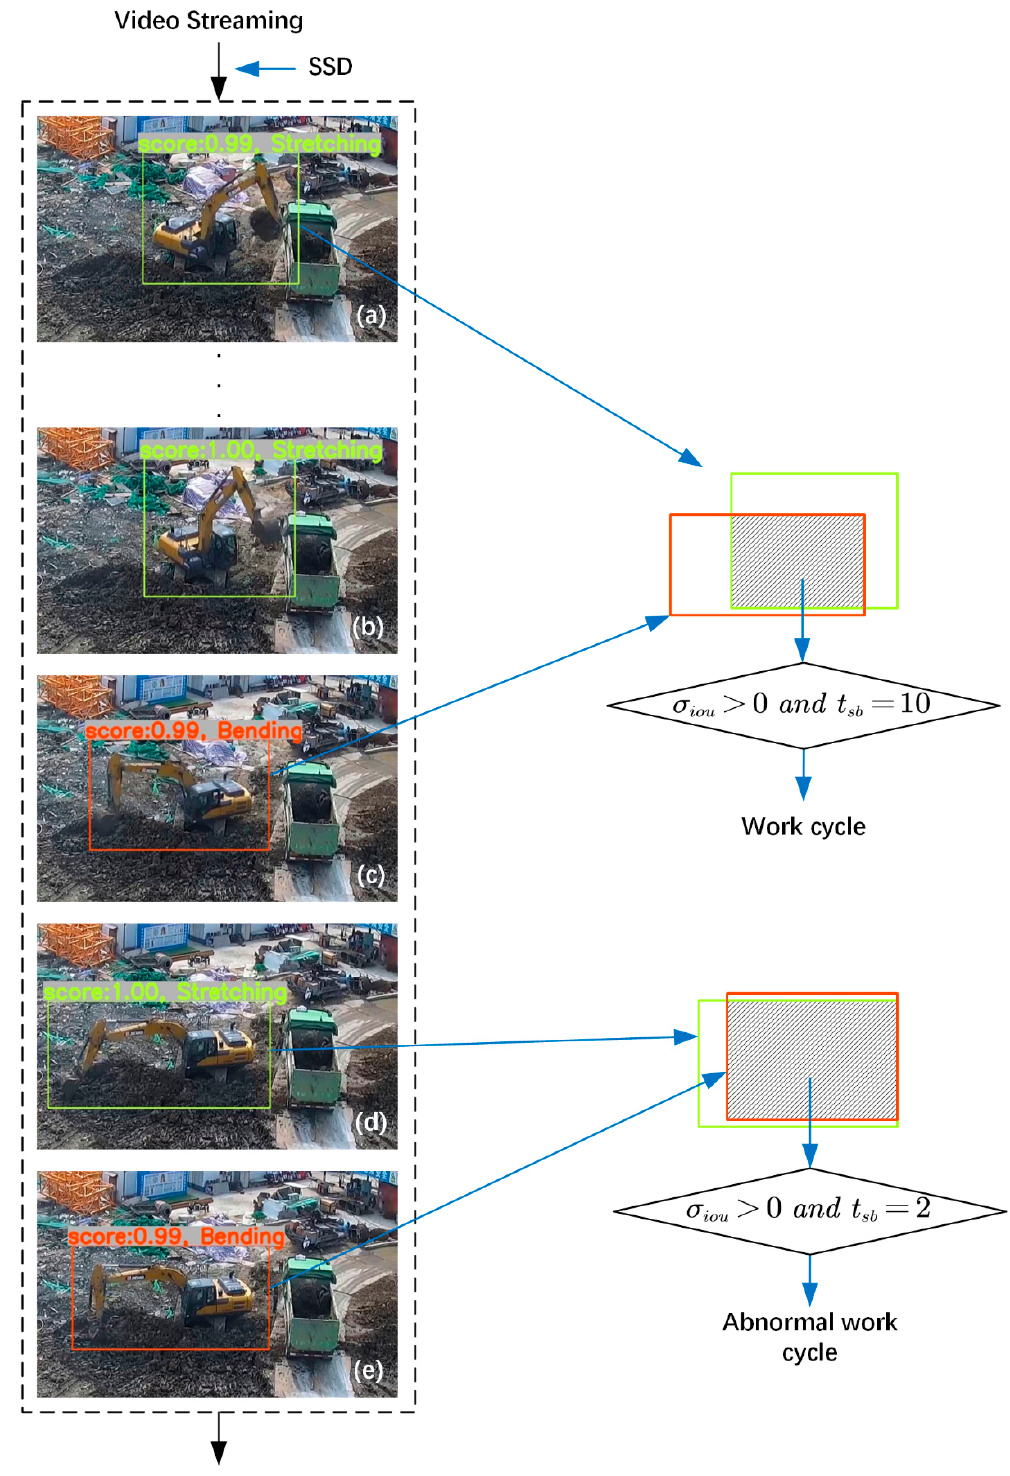
Figure 6. Work cycle recognition. ( a ) “Stretching” was recognized at 09:34:03; ( b ) “Stretching” was recognized at 09:34:11; ( c ) “Bending” was recognized at 09:34:13; ( d ) “Stretching” was recognized at 09:34:15; ( e ) “Bending” was recognized at 09:34:17.